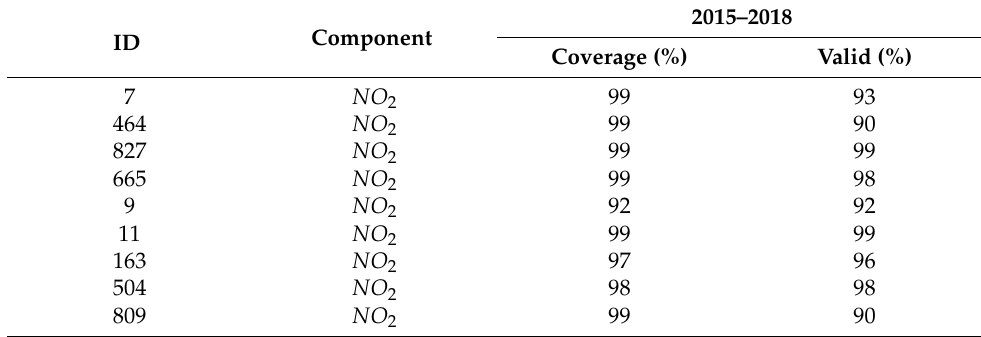
Table 2. Metadata of the nine monitoring stations measuring NO 2 located in the municipality of Oslo.